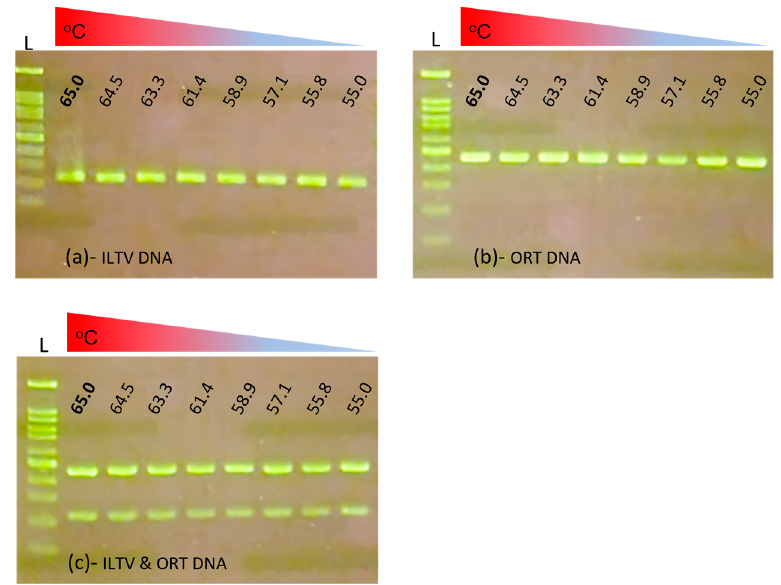
Figure 1. Optimization of annealing temperature. Multiplex PCR reactions were performed with single DNA template of ILTV ( a ) or ORT ( b ) and with double-DNA of ILTV and ORT ( c ). One hundred bp DNA ladder (L); the lowest band was on hundred bp and the brightest band was five hundred bp.